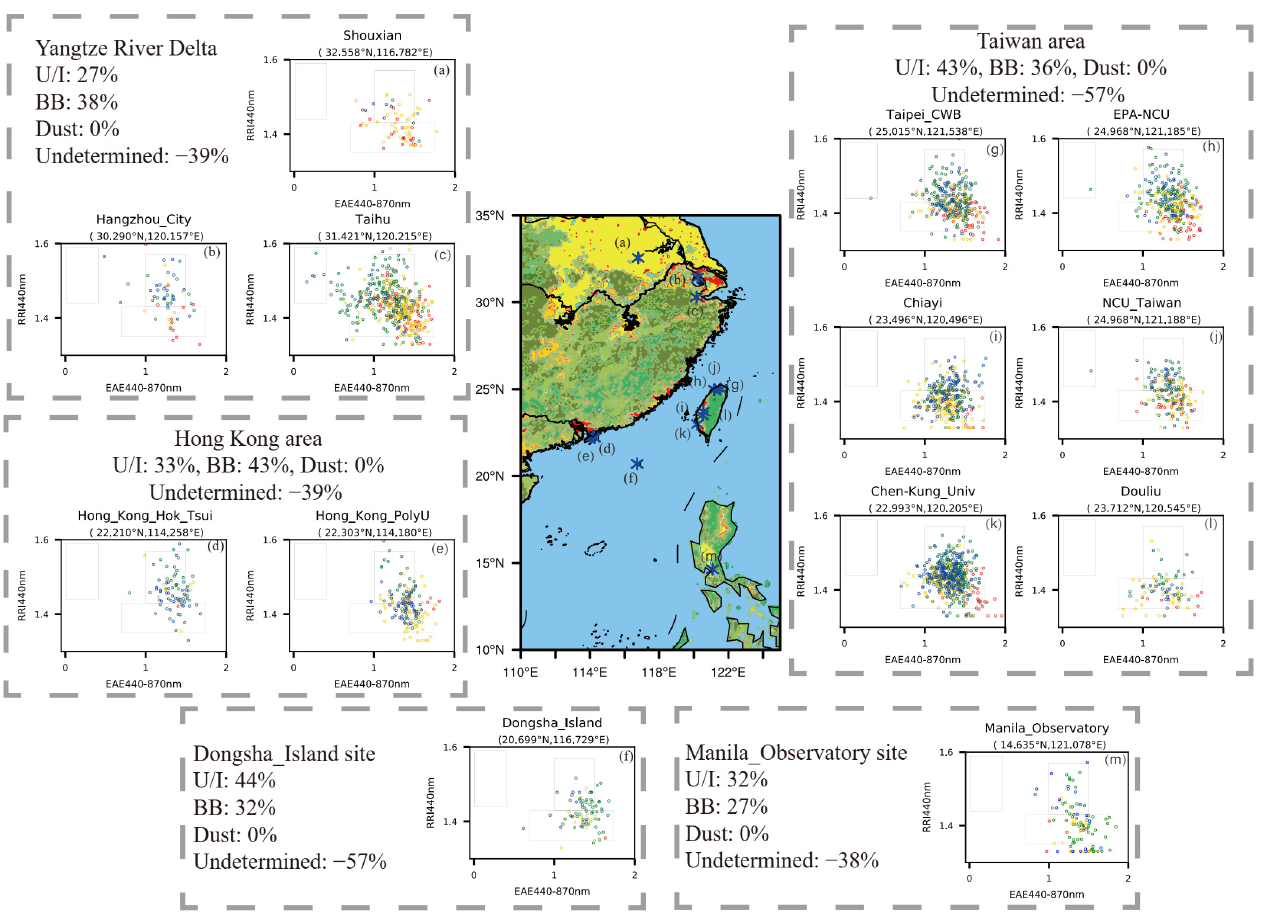
Figure 8. The same as Figure 6 but for the aerosol classification by the 2-D clustering method using RRI and EAE at the AERONET sites ( a – m ) in Southeast Asia.